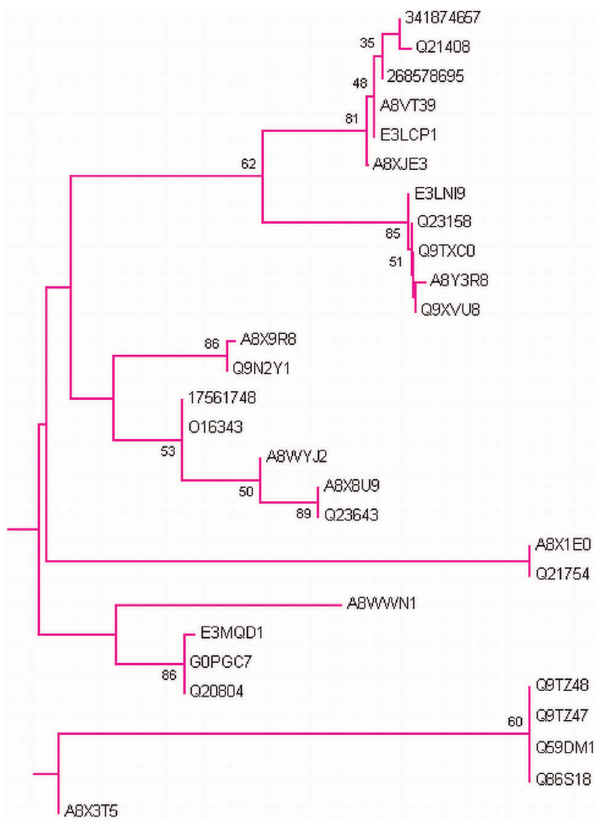
Figure 9. Group V. Tree showing all proteins included in this group.